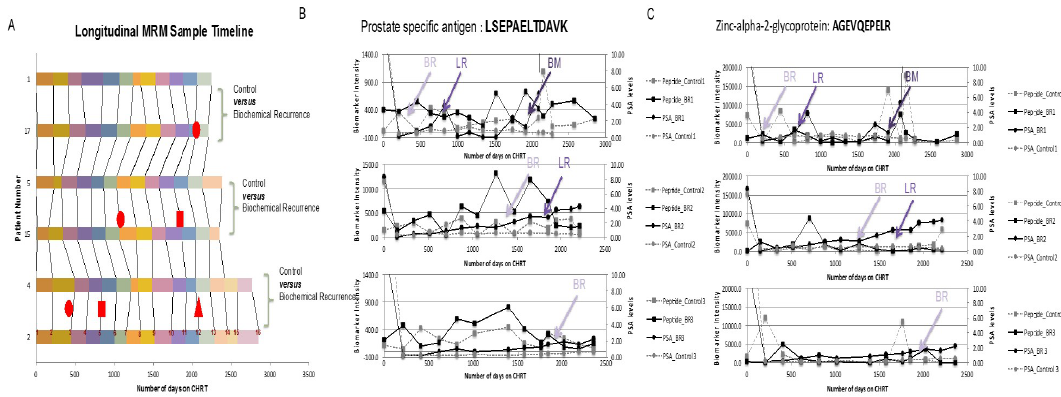
Figure 6. Longitudinal Evaluation of Candidate Prostate Cancer Biomarkers in Patient Serum Samples: Serum samples collected from patients who had failed treatment with CHRT ( n = 3) and time-matched controls still responsive to CHRT ( n = 3) ( A ) were used to longitudinally evaluate the expression of multiple markers of PCa, including PSA ( B ) and zinc-slpha-2-glycoprotein ( C ) via MRM measurement of proteotypic peptides. Figure adapted from Tonry et al. 2015 [247].